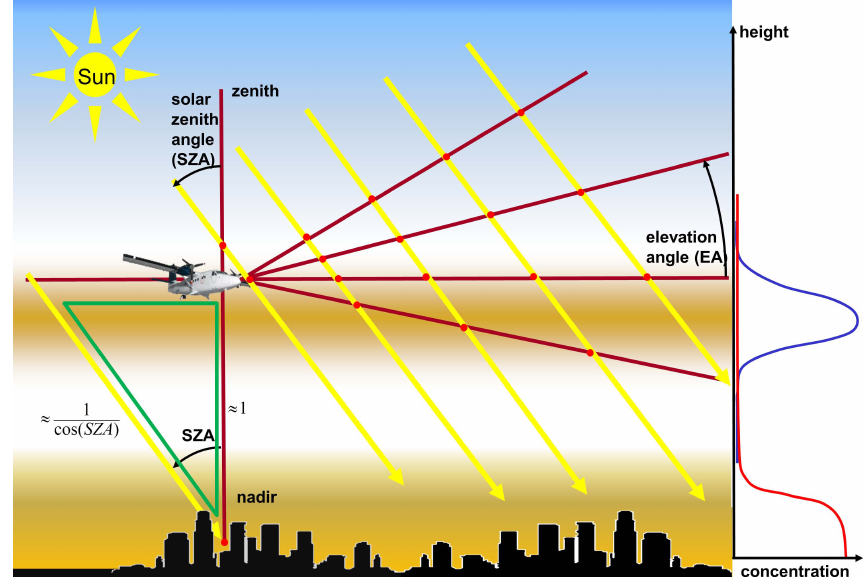
Fig. 1. Schematic of the AMAX-DOAS measurement principle. Individual EAs contain different amounts of information from different layers in the atmosphere. The inset (green triangle) illustrates the geometric approximation used to convert nadir dSCDs to